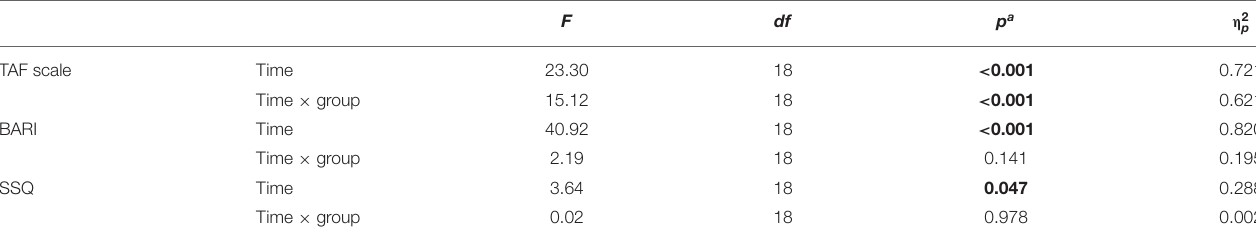
TABLE 3 | Statistics of the repeated measure analyses with the within-subject-factor Time (pre-treatment, post-treatment, and follow-up) and the between-subject-factor Group (ERP vs. MCT). F df p a η 2 p TAF scale Time 23.30 Time × group BARI Time SSQ Time Time × group